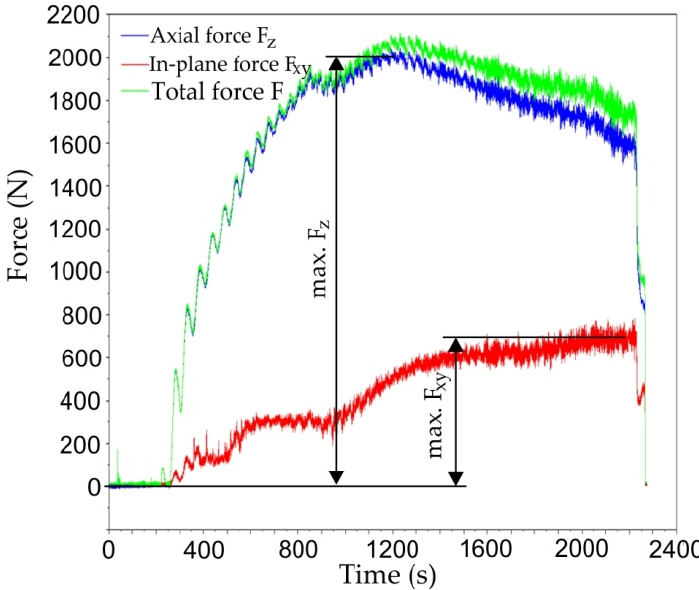
Figure 10. Total force F and components of total force F xy and F z for the VWACF produced with run 15.